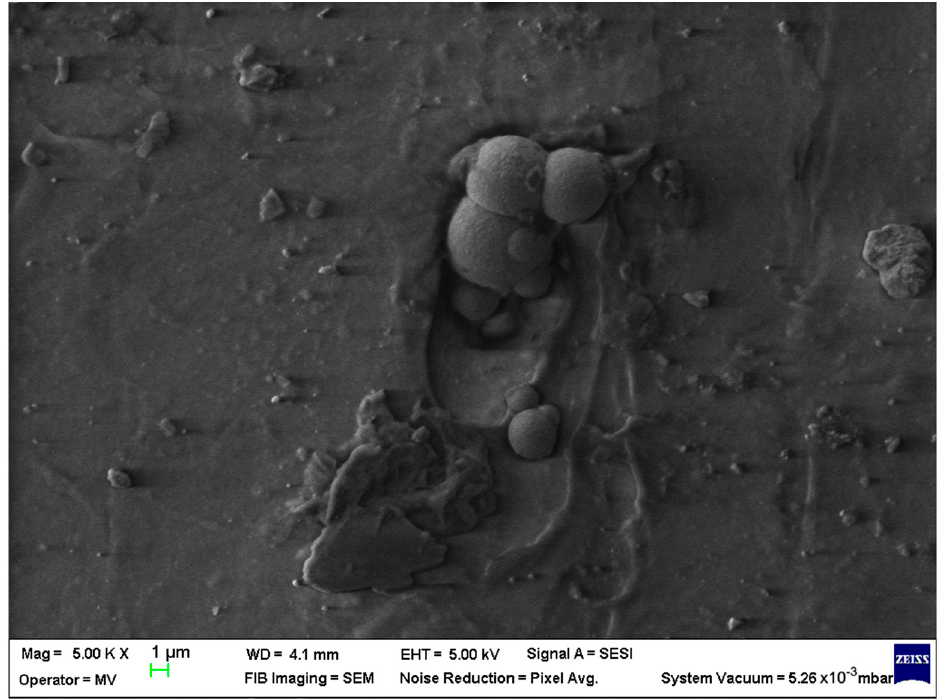
Figure 15. SEM micrograph of PET–HDPE–Fe composite (M15) sample at T 0 (1 μ m scale).